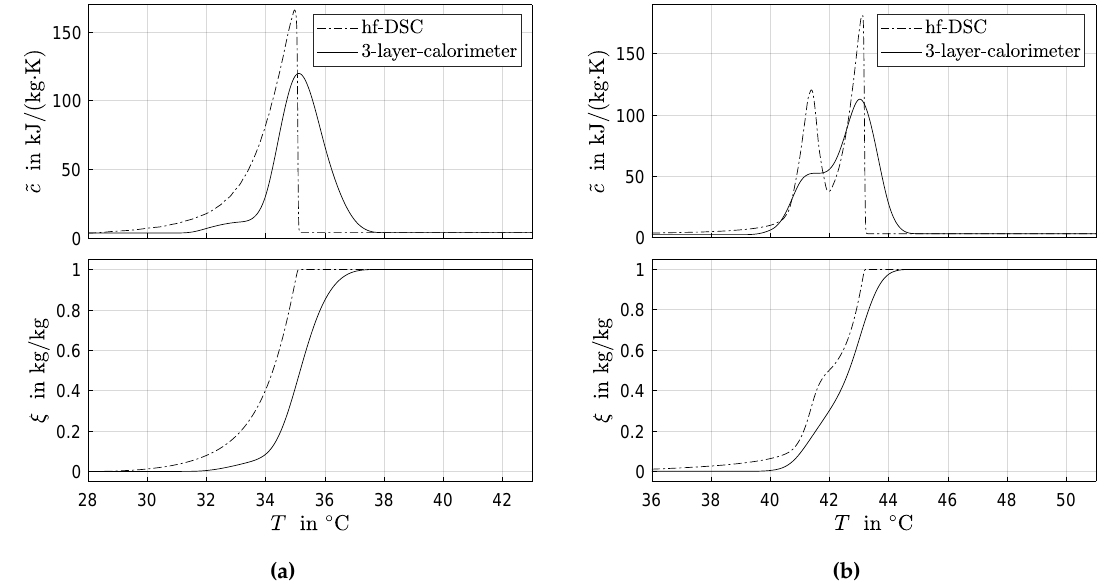
Figure 6. Identified consistent phase transition functions and corresponding apparent heat capacity curves using spline interpolation for RT35HC ( a ) and RT44HC ( b